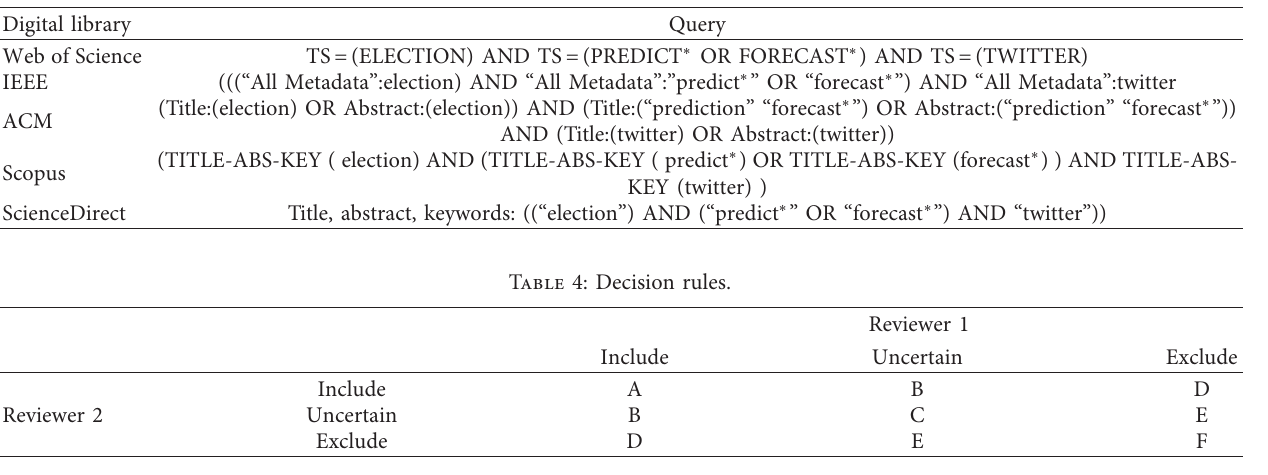
Table 3: Example of queries in Digital Libraries.